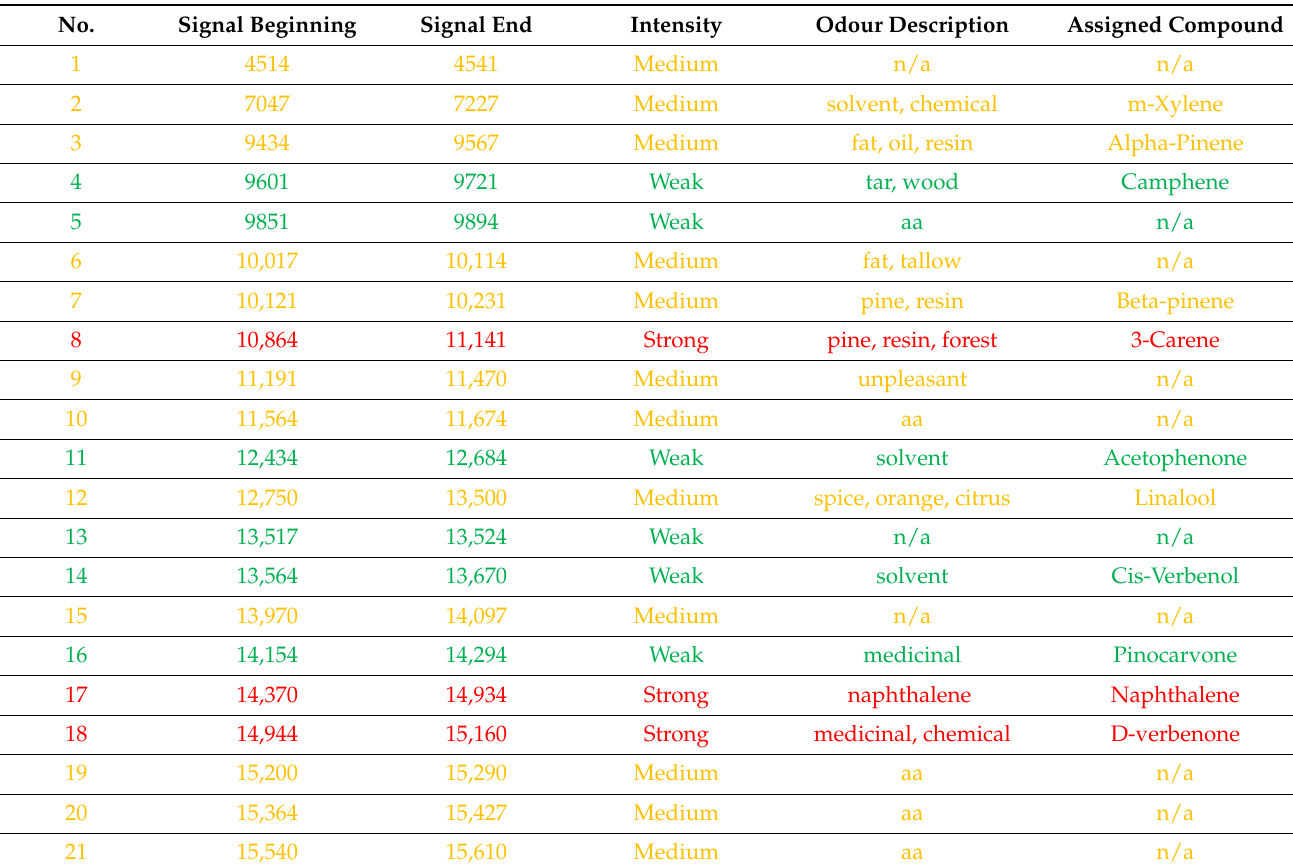
Figure 5. Chromatographic spectrum with the applied odour signals obtained for the air sample collected from the office room during renovation. Table 1. Identification of odour signals obtained for the air sample collected in an office room during